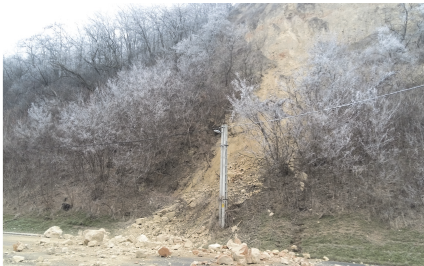
Figure 3: Sliding of the loess bluff to the road No. 6 (photo made by the